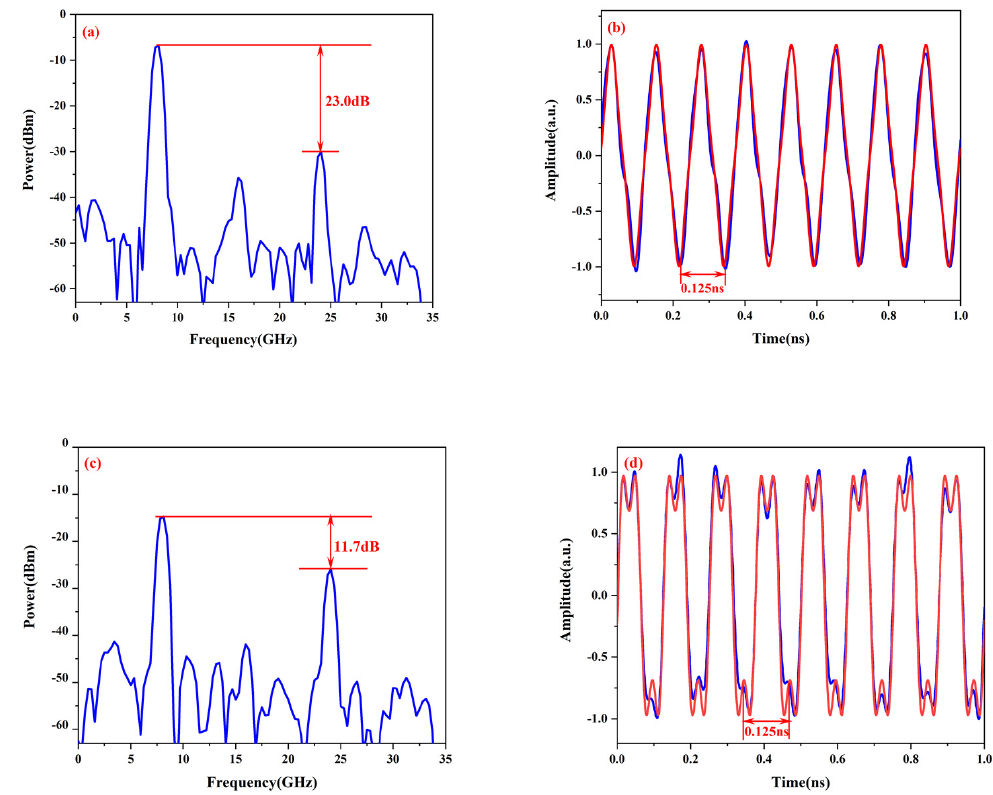
Figure 7. Experiment results. ( a ) Electrical power spectra and ( b ) waveforms of the generated triangular pulse trains with repetition rates of 8 GHz. ( c ) Electrical power spectra and ( d ) waveforms of the generated square waveform with repetition rates of 8 GHz. (Blue curve in the figure is the measured result, and the red curve is the theoretical